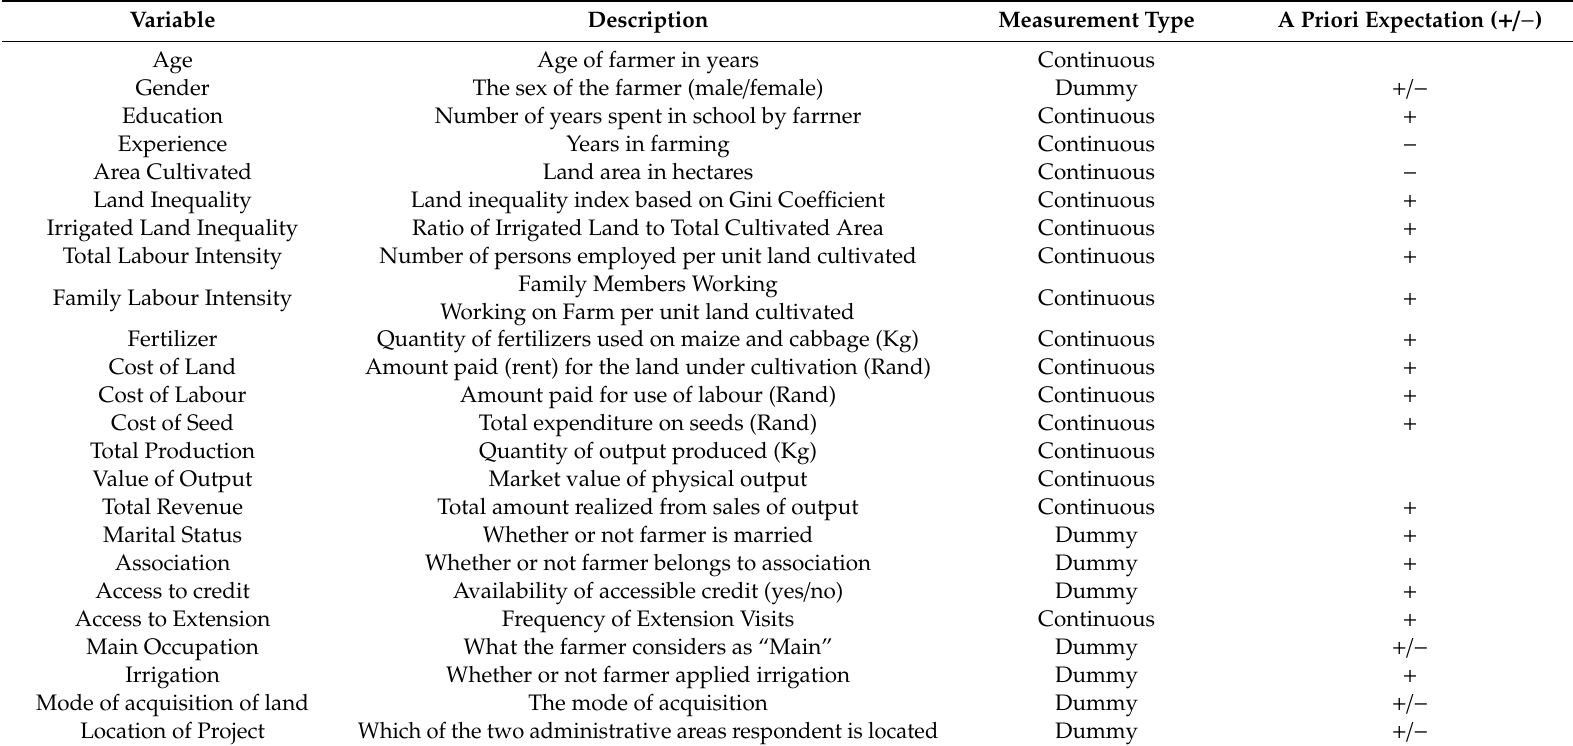
Table 1. Data collected / transformed for the